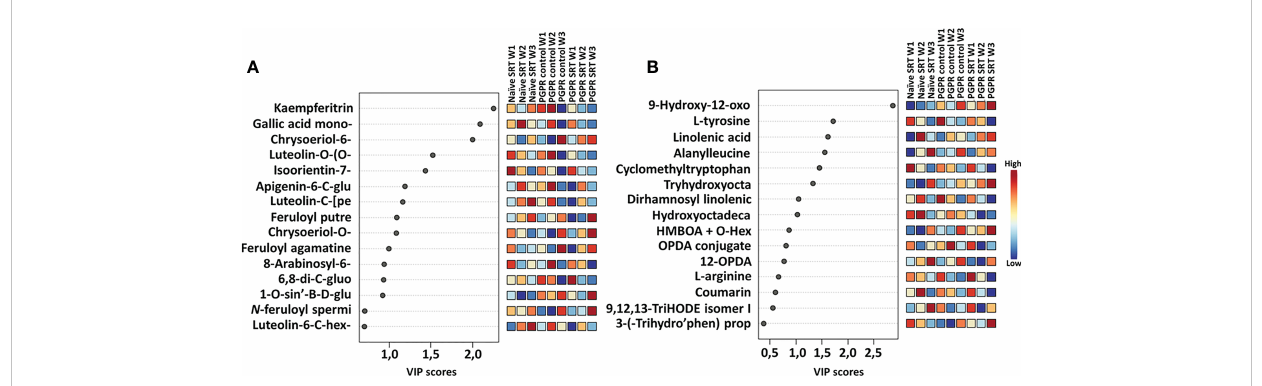
FIGURE 3 VIP score-plots of discriminant features derived from the PLS-DA analysis. The VIP scores display discriminant features in PGPR-primed- unchallenged (control) vs. PGPR-primed-challenged (SRT) plants vs. non-primed infected (SRT) plants for the Gariep cultivar samples over a period of three weeks post-infection. Selected metabolites (VIP score ≥ 1) in infected plants were compared to those in control plants at the given time point. The fi gures show differential accumulation of signi fi cant secondary (A) and primary (B) metabolites in infected plants. Some metabolites increased over time while others decreased. In addition to the effects of priming on the plant metabolome, Pst infection also induced the up- and down-regulation of metabolites in primed as compared to their non-primed counterparts. The data projected above were median-normalised, log